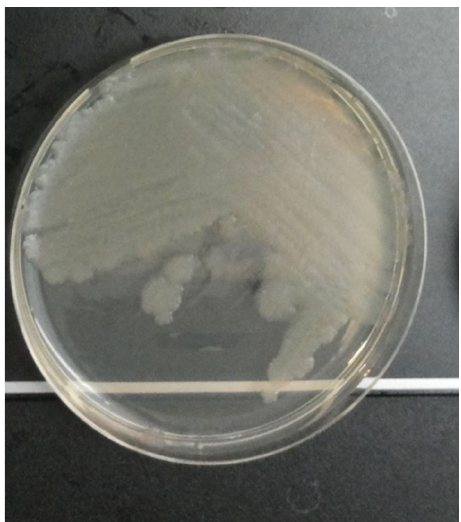
Figure 2. Pseudomonas syringae pv. syringae colonies on Luria-Bertan i (LB ) medi um plate (Author personal